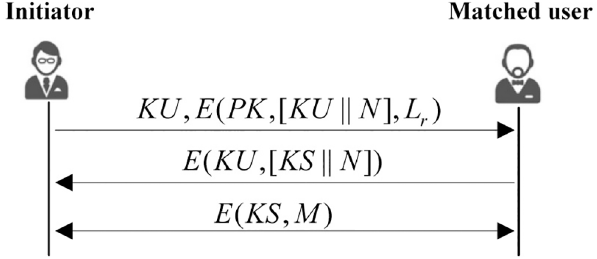
Fig 3. The key exchange